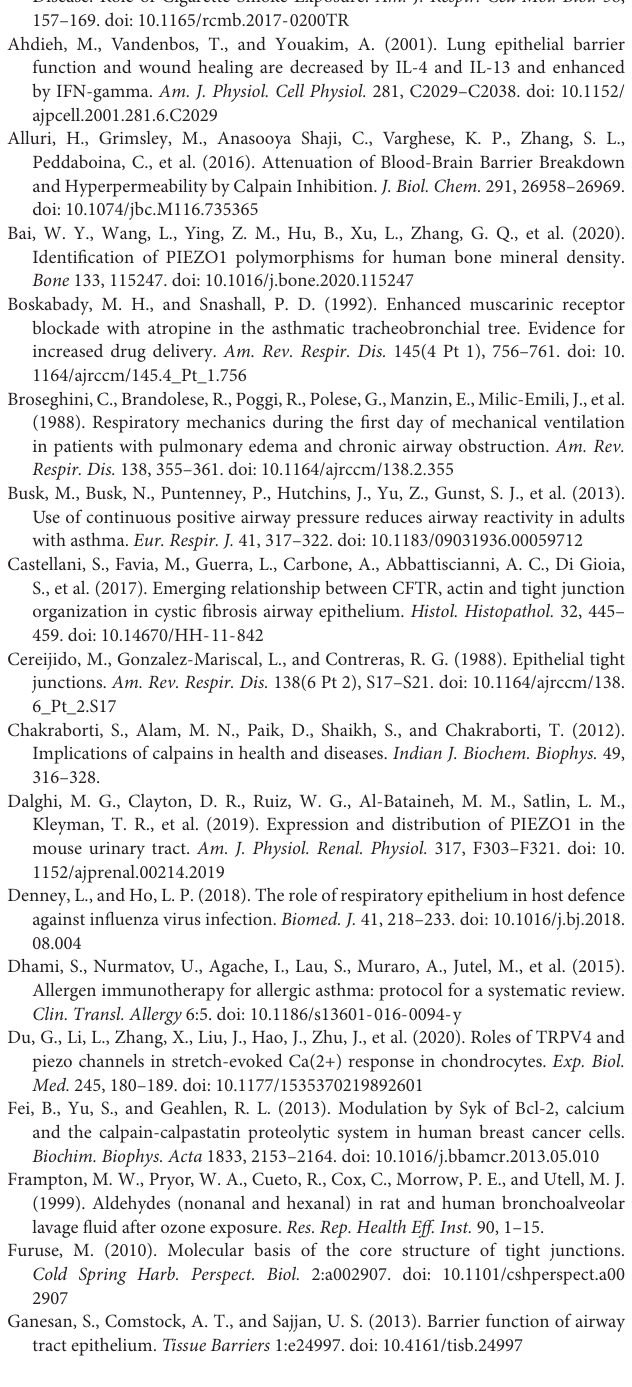
Supplementary Figure 2 | Western blot assay to detect the piezo-1 protein. Cells were propagated under normal atmospheric pressure. HSAECs were transfected with control (CTL) siRNA or piezo-1 siRNA. Piezo-1 levels are